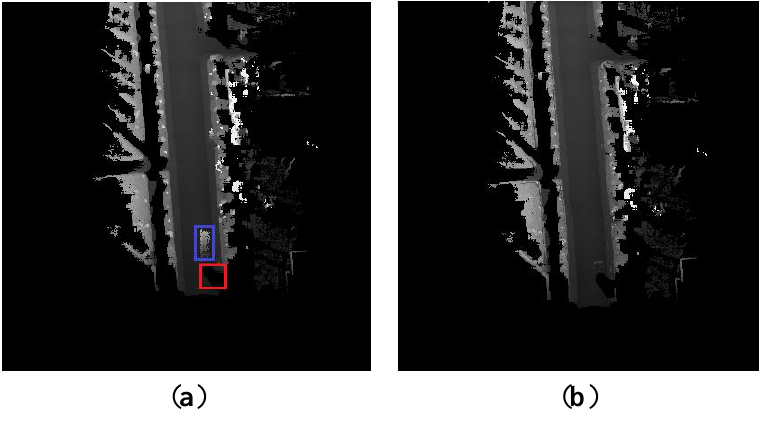
Figure 4. The local DEM in dynamic environment. ( a ) The bad result. ( b ) The result of our